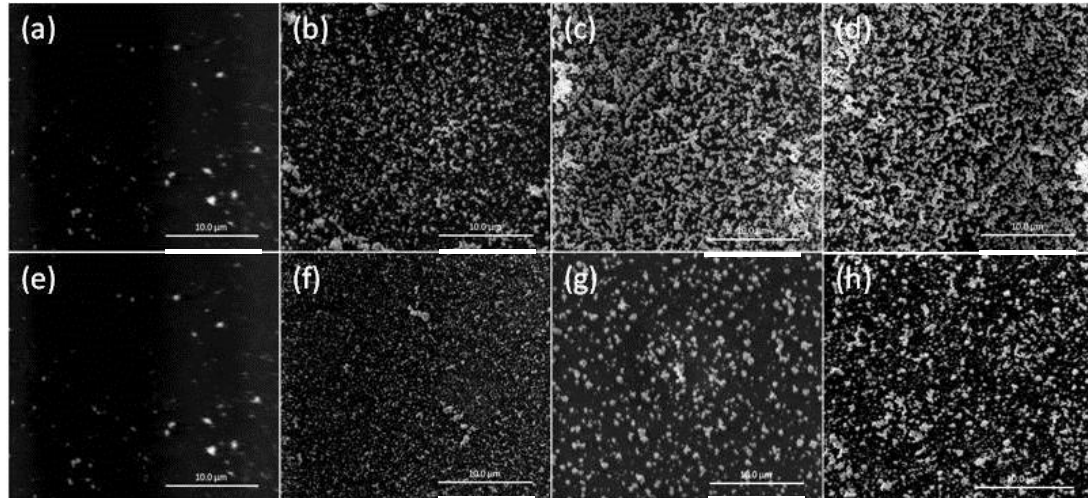
Figure 6. SEM surface images of the PIMs listed in Table 2. Aliquat 336, 20 wt %; DD, ( a ) 0; ( b ) 5; ( c ) 10; ( d ) 15 wt %; 2-nitrophenol octyl ether (NPOE); ( e ) 0; ( f ) 5; ( g ) 10; and ( h ) 15 wt %. The white bars are equal to 10 μm.